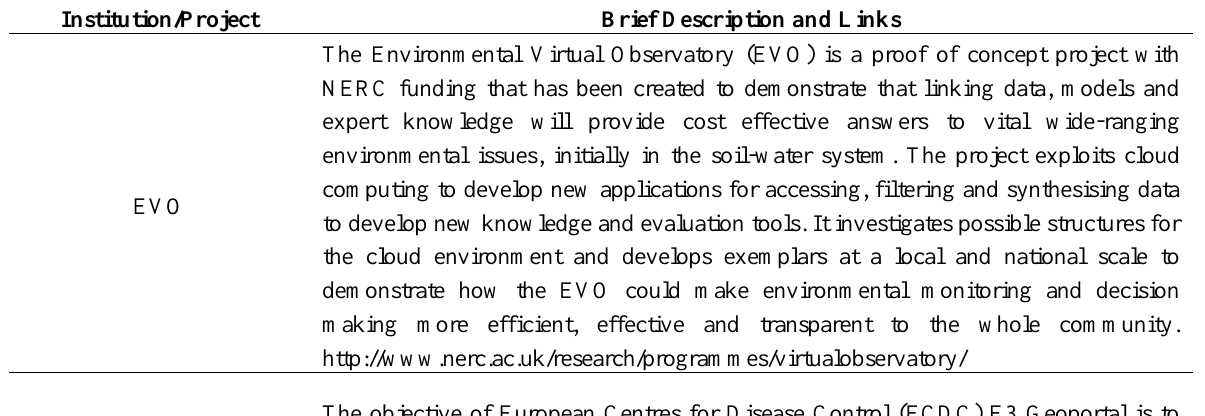
Table 1. Exemplar database linkages/mashups of climatic and environmental with human health data.